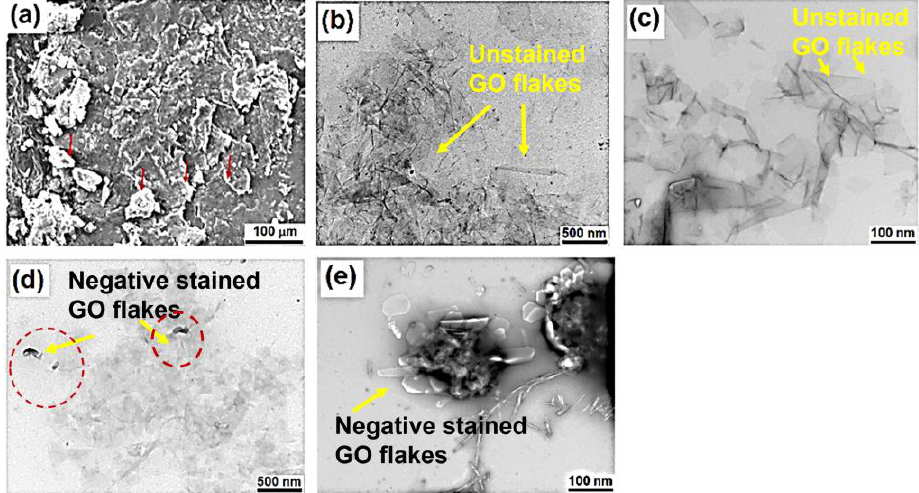
Figure 2. ( a ) SEM image of dried GO powder, ( b , c ) TEM image of unstained GO powder, and ( d , e ) TEM images of GO negatively stained loaded with CHL.